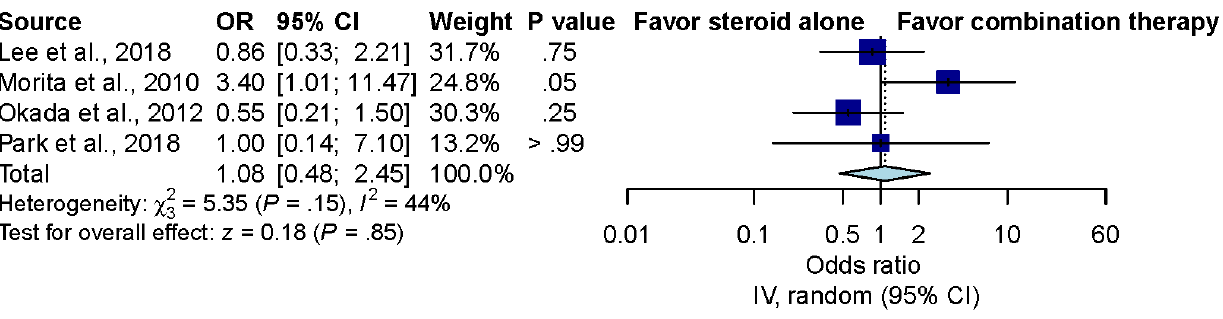
Figure 2. Overall effect of steroids alone and combination therapy in ALHL patients [9–11,20].